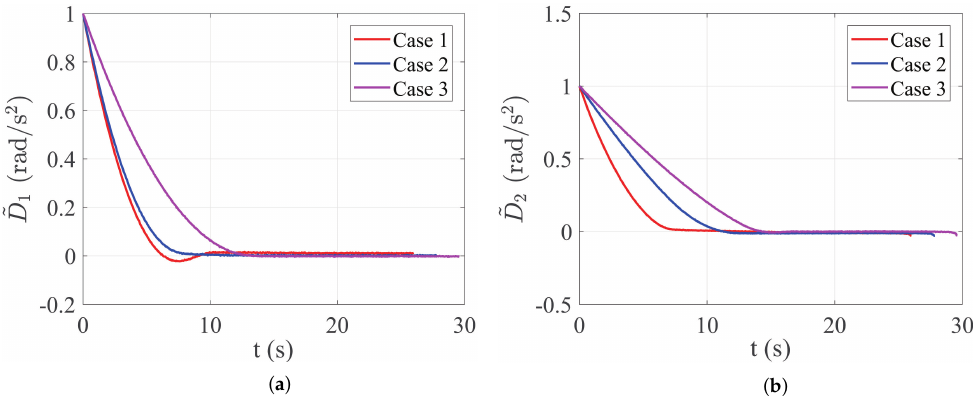
Figure 12. Variations of estimation errors against variable maneuvering targets: ( a ) estimation errors in pitch plane; ( b ) estimation errors in yaw plane.